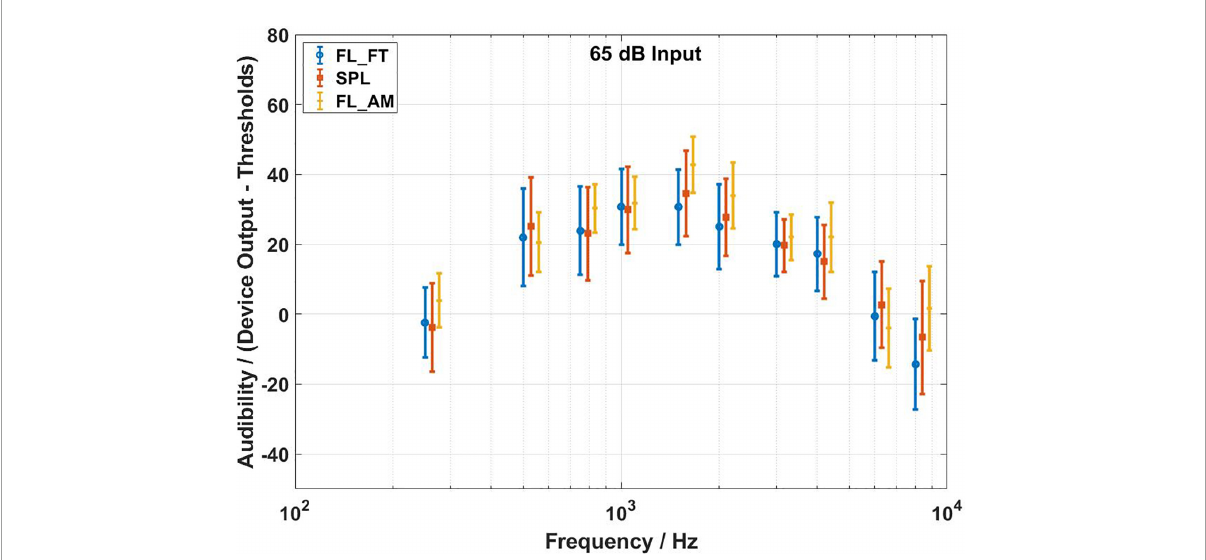
FIGURE8 Audibility estimates for the force transducer method, the ear canal method, and the artificial mastoid method at 65 dB SPL input level. Average values over all subjects. Error bars indicate ± 1 SD. The FL_FT indicates the force transducer method, the SPL indicates the ear canal method, and the FL_AM indicates the artificial mastoid method.